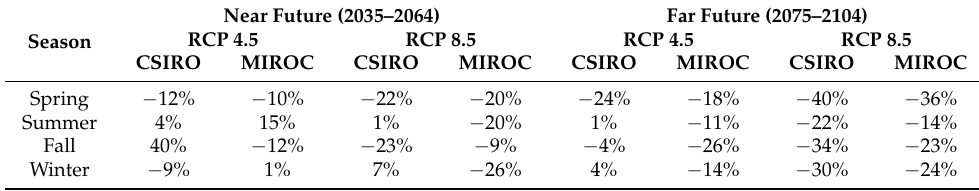
Table 3. Seasonal rainfall